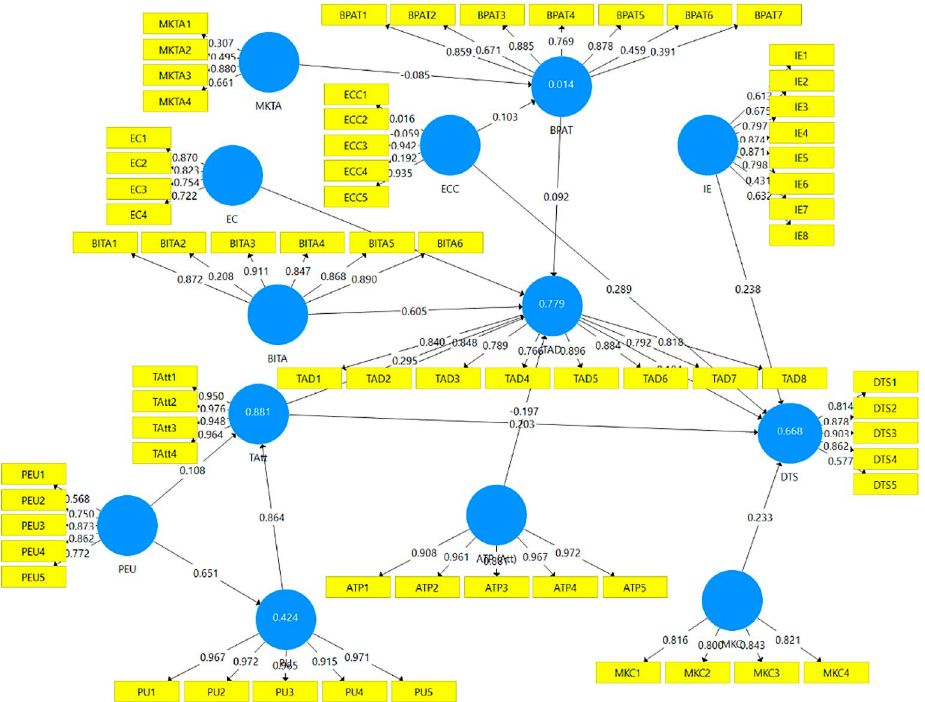
Figure 2. Initial theoretical model with